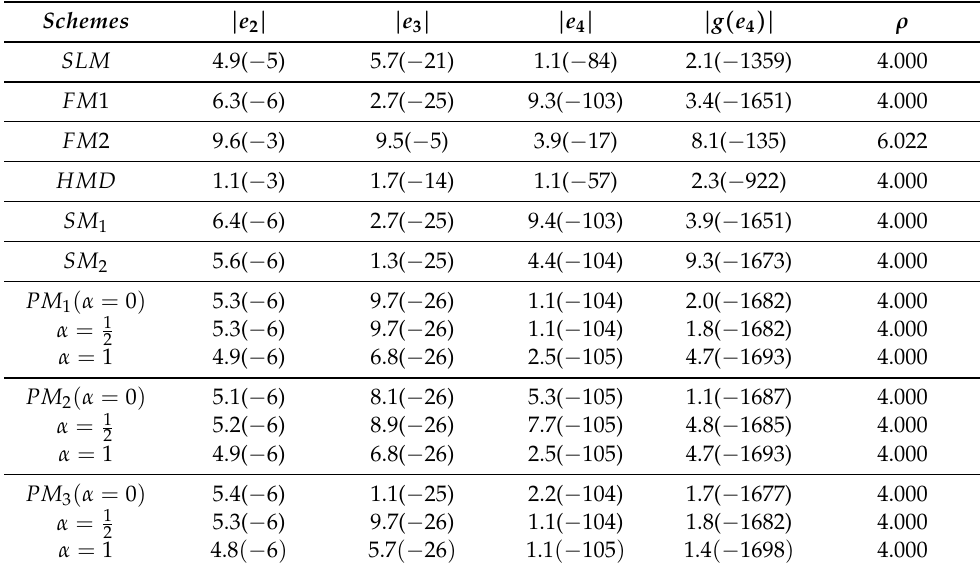
Table 2. Numerical results of Example